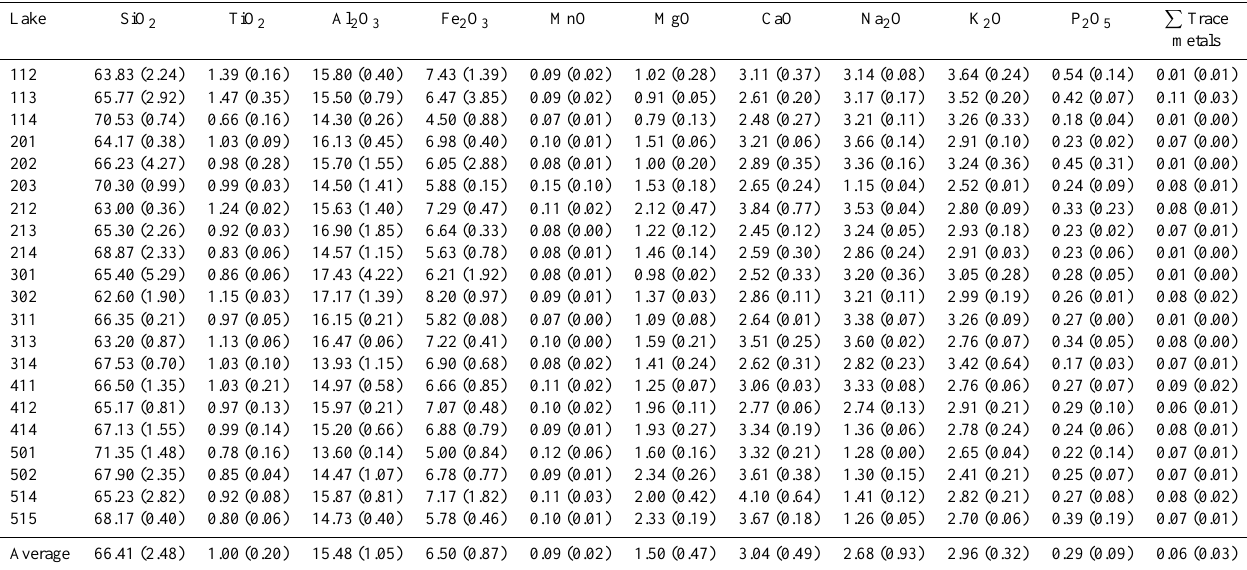
Table 2. Total element concentrations (weight%) of the B horizons for each catchment. Standard errors are shown in parentheses.